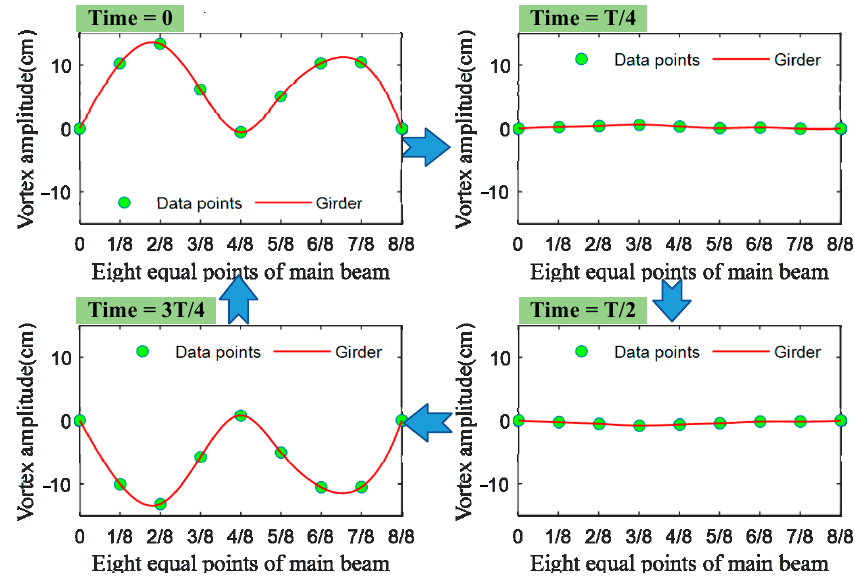
Figure 10. In a single period T of VIV, the longitudinal motion configurations of the bridge (the four times represent the maximum peak, the peak is 0, the trough is the largest, and the trough is 0).